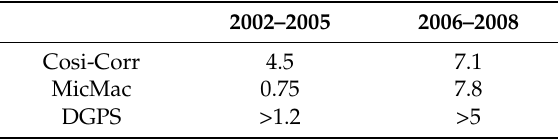
Table 2. South-north component of the shift measured at the Vira DGPS Station by MicMac, Cosi-Corr and the measure of displacement by DGPS at the same location. The values of Cosi-Corr and MicMac are the average values of shift on a square window of five pixels centered on the DGPS